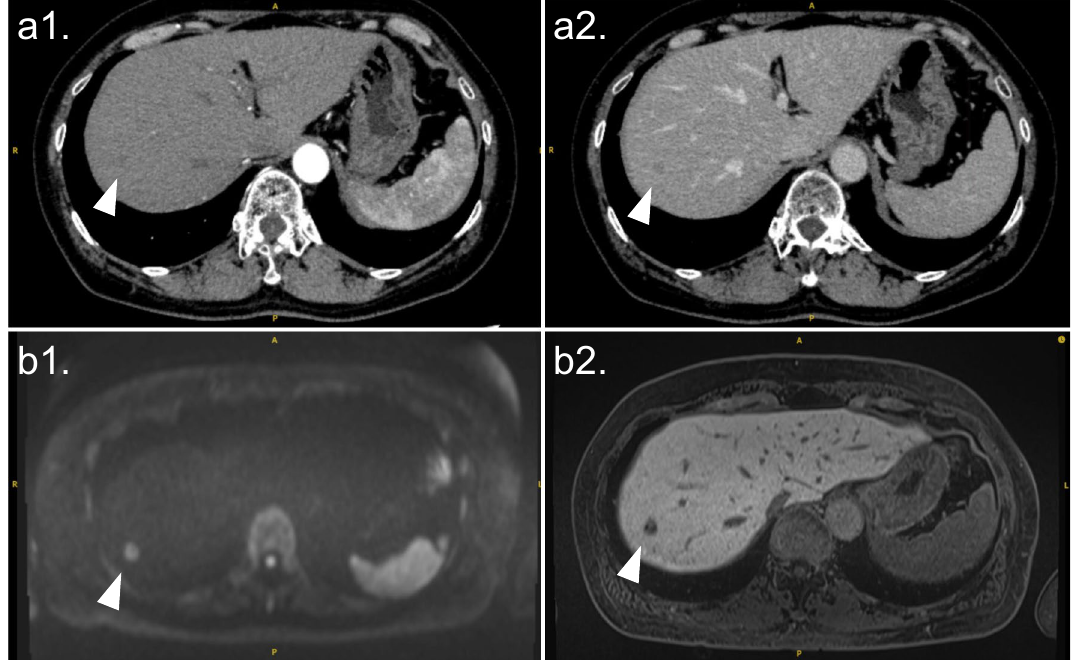
Fig. 1 Preoperative imaging examinations. MDCT shows a low-density nodule, about 1 cm in diameter during the arterial phase ( a1 ) and ring enhancement during the delayed phase ( a2 ) in liver segment 8. EOB-MRI shows restricted diffusion ( b1 ) and a low-signal intensity mass during the hepatobiliary phase ( b2 ) in liver segment 8. MDCT multidetector computed tomography, EOB-MRI Gd-EOB-DTPA-enhanced magnetic resonance